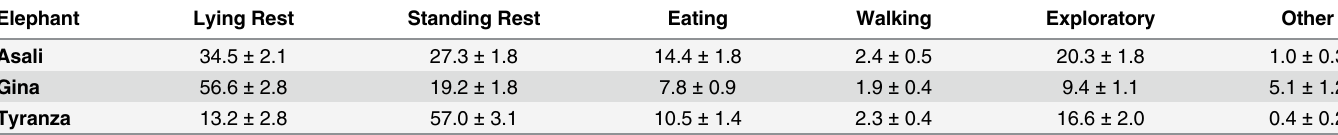
Table 2. Percent of nocturnal, indoor behavioral scans (mean ± standard error) the elephants spent engaged in each behavioral category through- out the entire duration of the study. Elephant